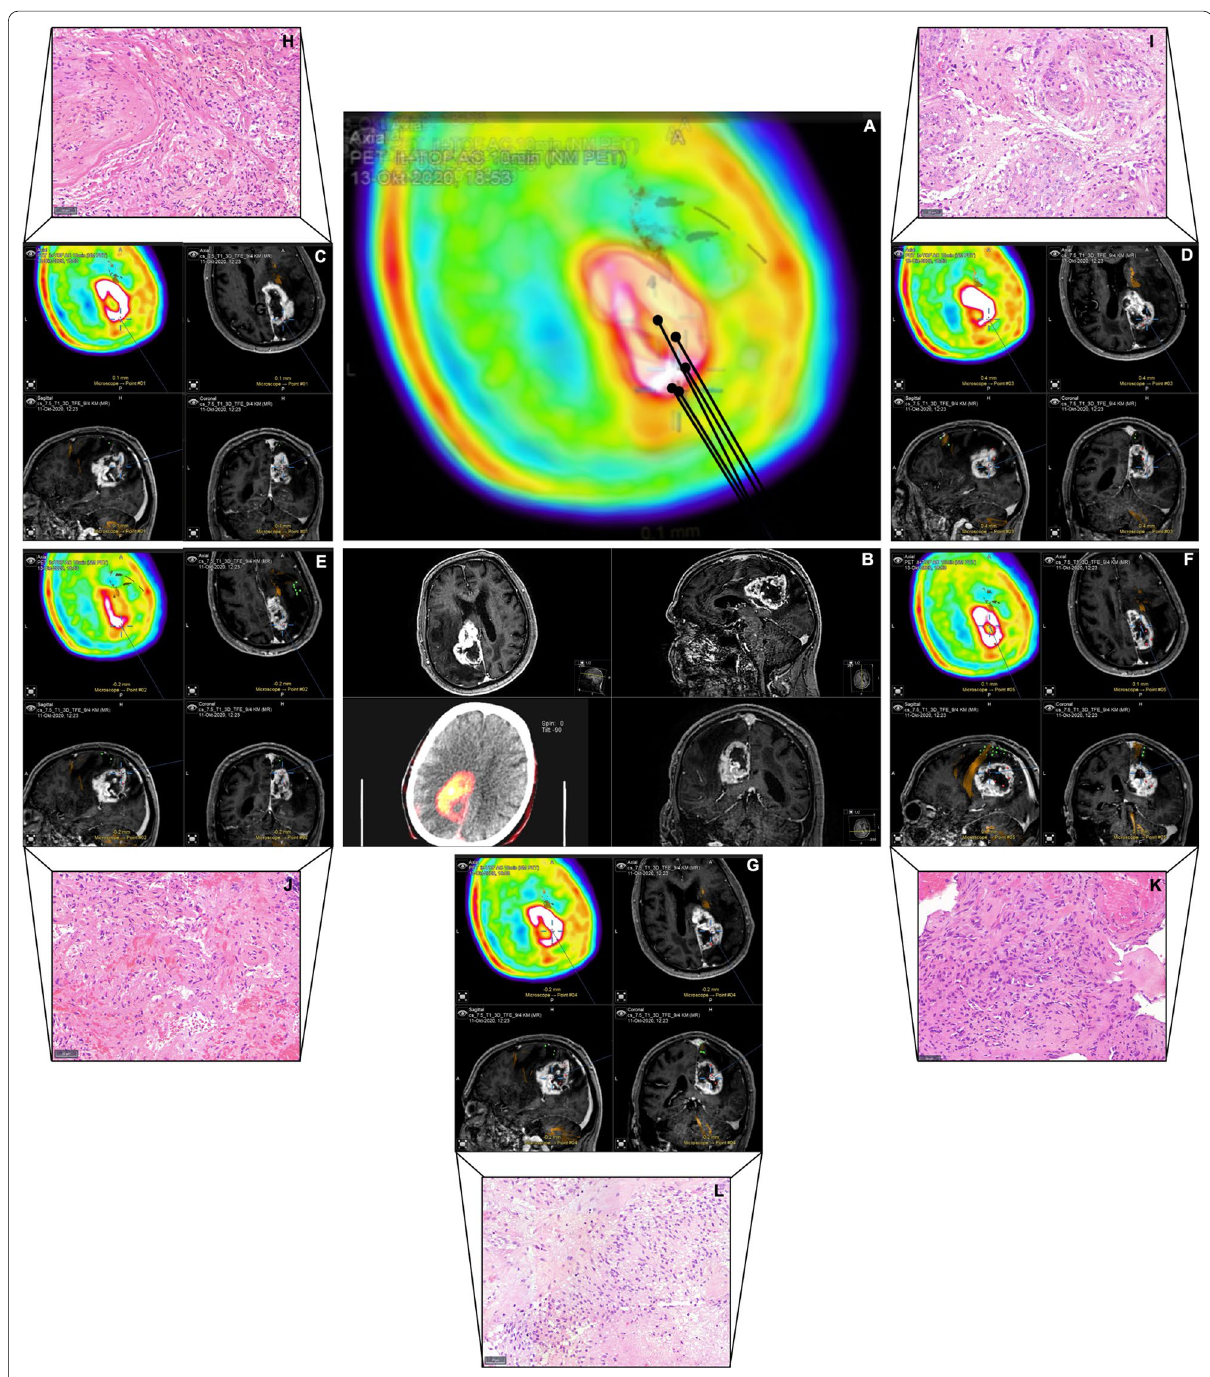
Fig. 2 Visualizing of biopsy location and corresponding histology—an example. In a , a fusion of the FET‑PET images with biopsy areas is depicted for better visualization. b Shows the preoperative MRI in all planes as well as the PET‑CT. In c – g , all biopsy locations for one patient are marked with an extract of corresponding histology ( h – l , scale bars 20 μm). g and h show high neovascularization, i – k low [18F] FET PET was significantly correlated with cel- revealed a significant increase of CBV in areas with “high” neovascularization ( p 0.003). In contrast, there lularity ( ρ 0.229, p 0.039) and CBV showed a trend = = = was a trend towards lower FA values in areas with higher towards correlation with cellularity, not reaching sig- neovascularization ( p 0.215). nificant levels ( ρ 0.129, p 0.106). MD and FA were = = =